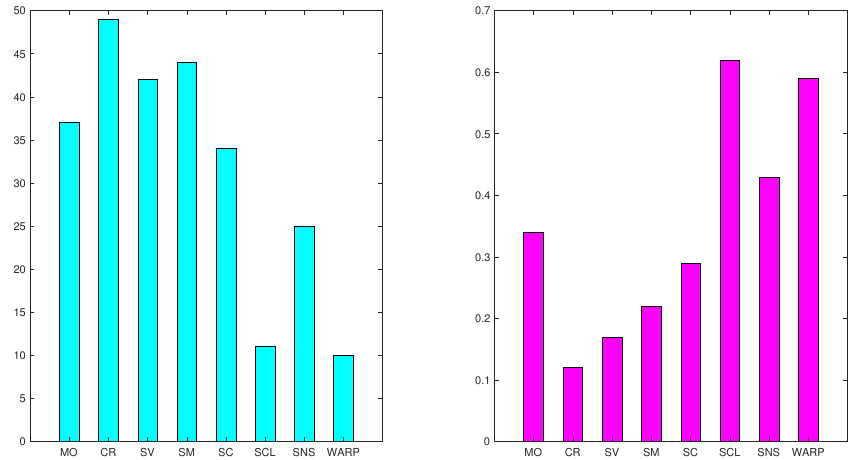
Figure 3. Histogram of subjective and objective assessment. ( left ) Subjective votes for the child image by participants. ( right ) Objective results by our proposed algorithm on the same